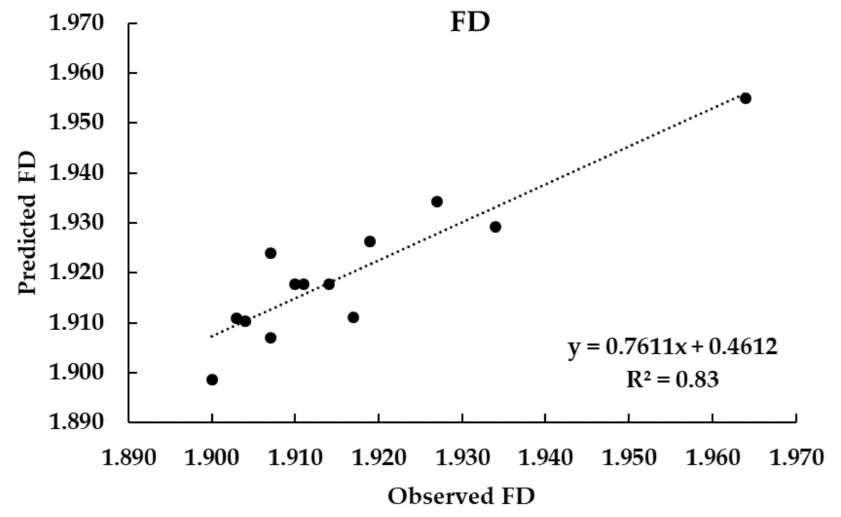
Figure 6. Verification of predictive model equations for fractal dimension (FD) values in ‘Glom Sali’ bruised guava by impact testing for 48